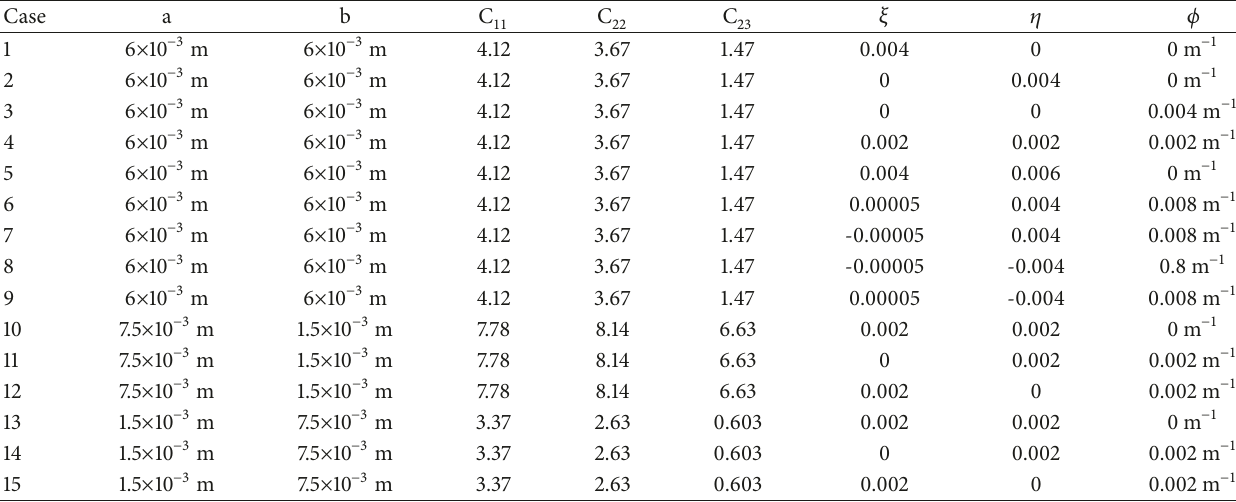
Table 4: Data adopted for the comparison of the methods, from [1].